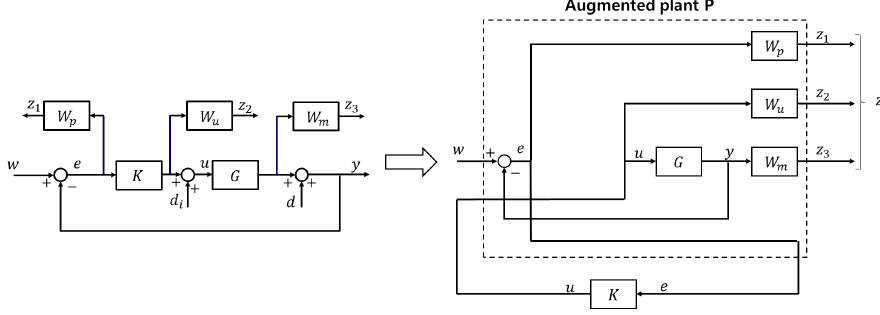
Figure 5. Block diagram of the H-infinity control algorithm with mixed sensitivity. The variables w , e , u , y , d , and are the reference input, tracking error, control out- put, system output, output disturbance, and the input disturbance, respectively. 𝑑𝑑 𝑖𝑖